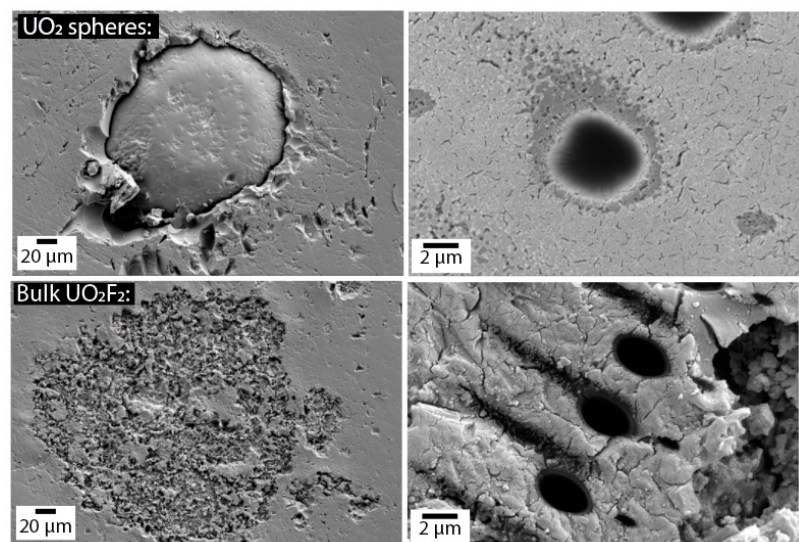
Figure 1. SEM images of two of the uranium compounds (UO 2 and UO 2 F 2 ) on the epoxy mount, showing representative 200 pA analytical craters. (Note, craters were made before the analyses conducted in this study, and the mount containing these materials was further polished before NanoSIMS analysis).